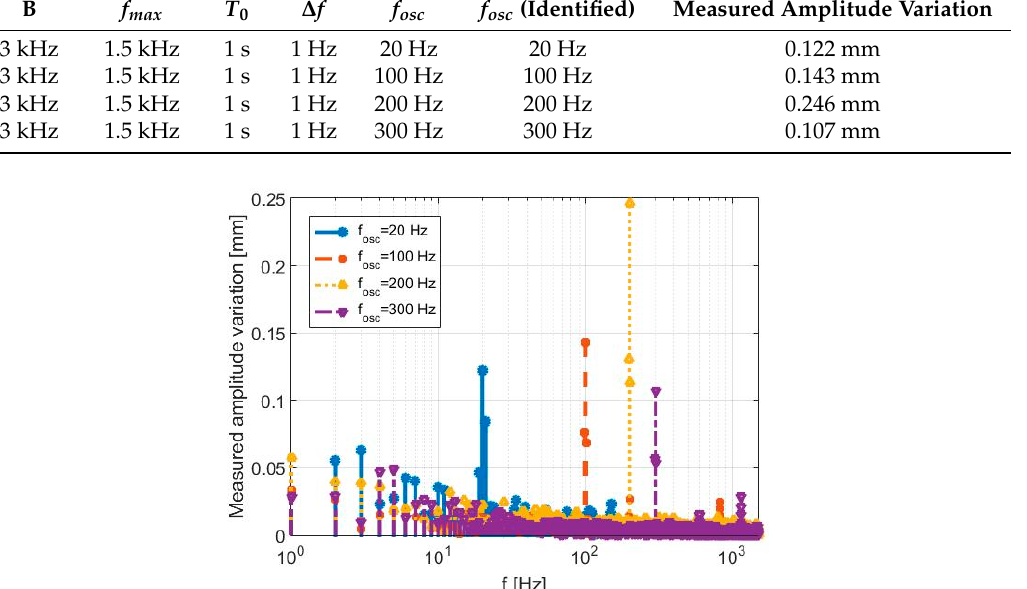
Table 5. Parameters and results of the experimental validation tests (first set).